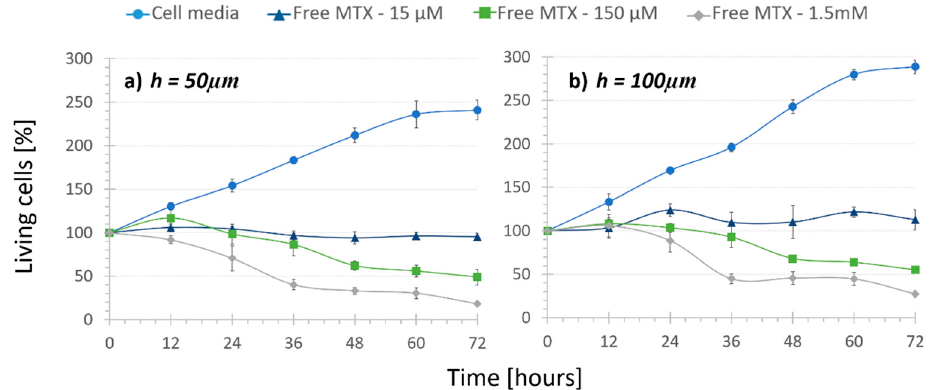
Figure 2. Cell viability under the recirculation of cell media and different concentrations of free MTX inside channels that were ( a ) 50 μ m high and ( b ) 100 μ m high (n = 4). Cell population increases with cell media recirculation, but decreases with an increasing amount of free drug recirculation.